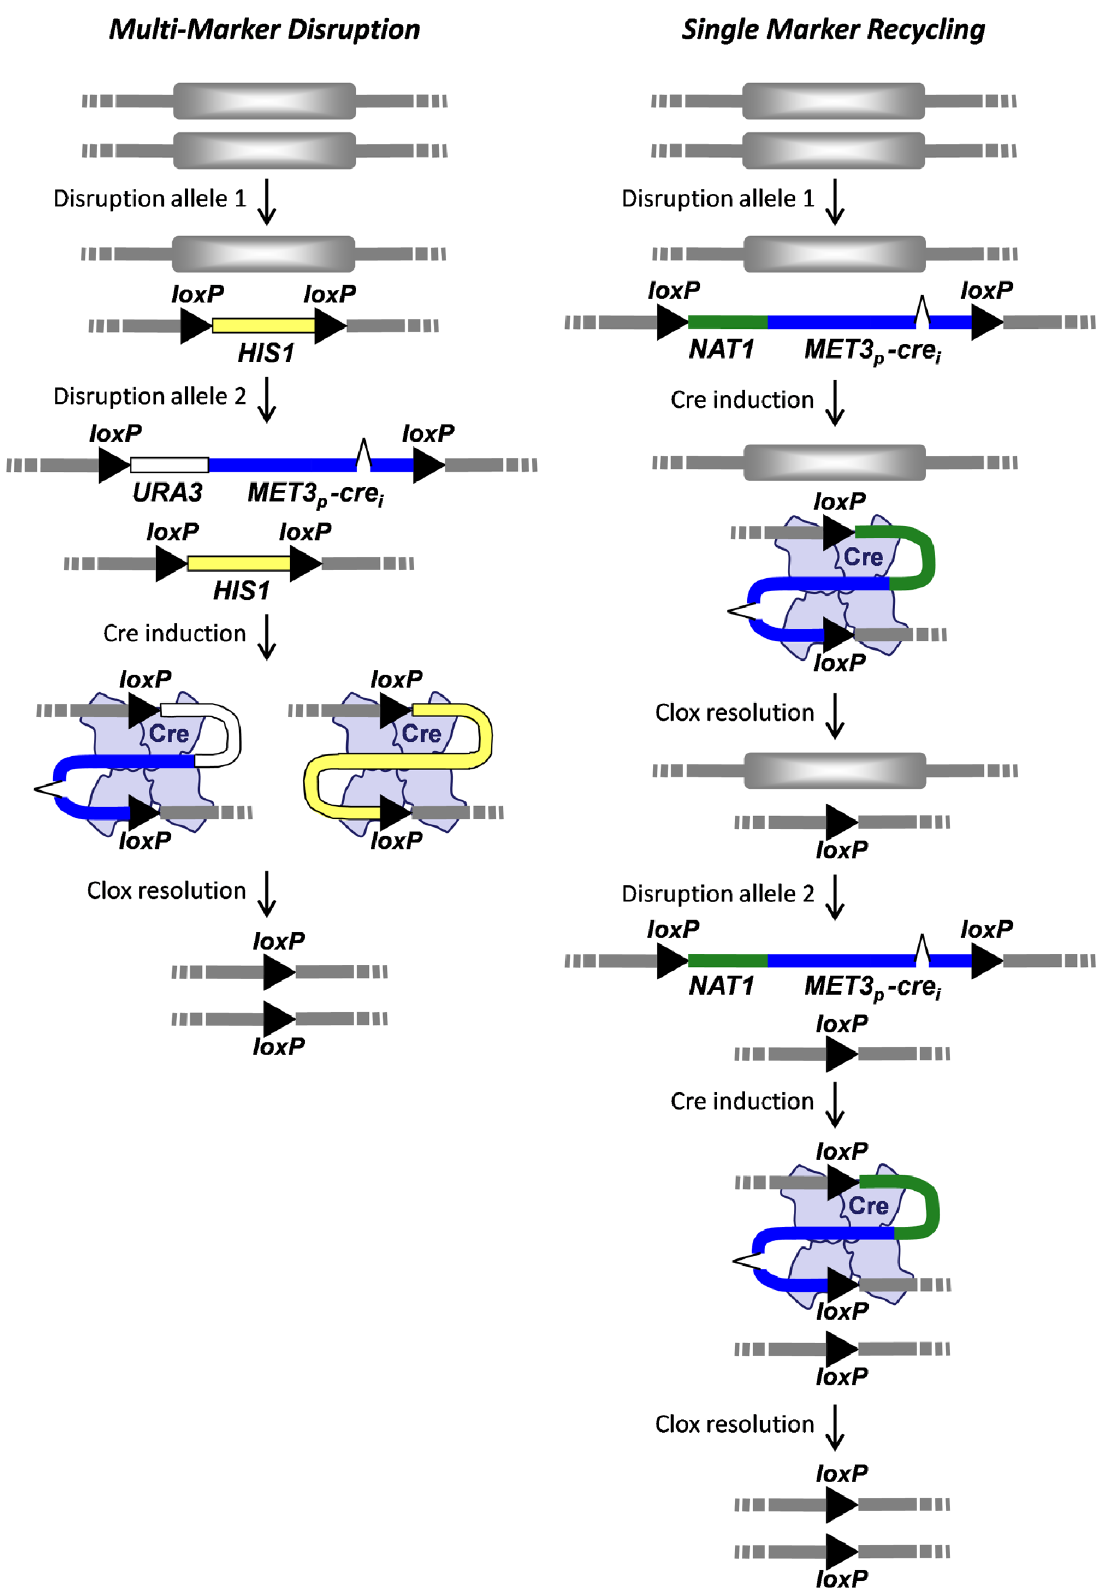
Figure 2. Cartoons illustrating the exploitation of Clox cassettes for multi-marker gene disruption and single marker recycling. (see text).